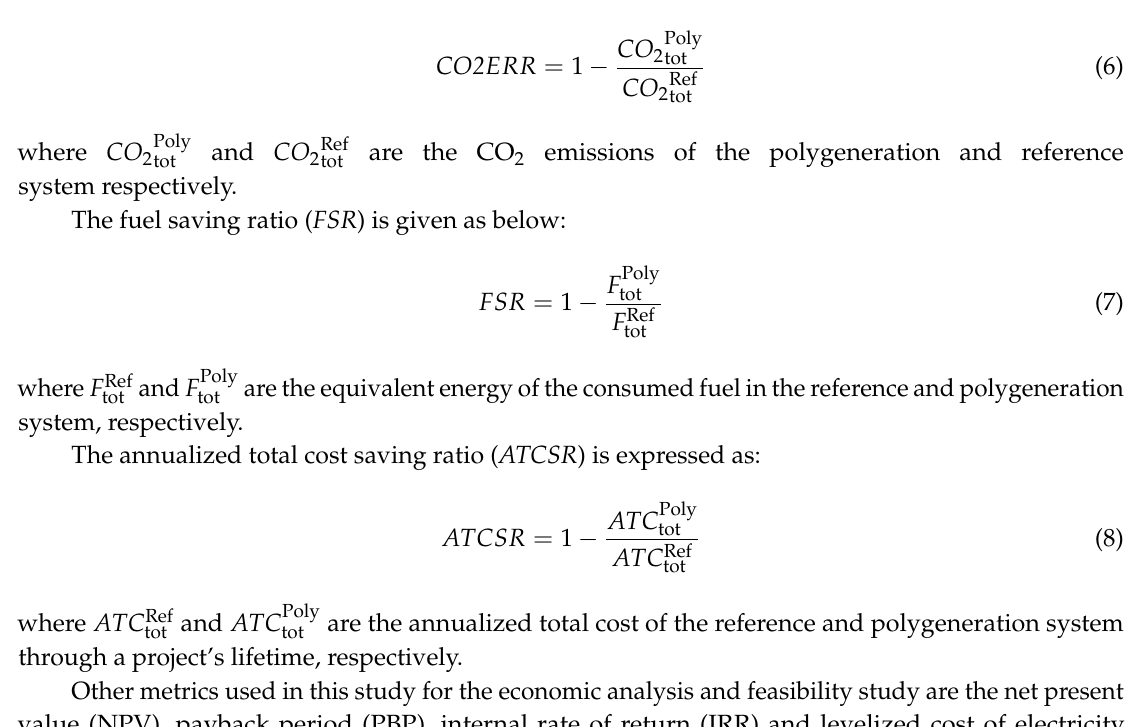
are embedded. Evaluation of the system in terms of energy, economy and environment is carried out in the performance analysis